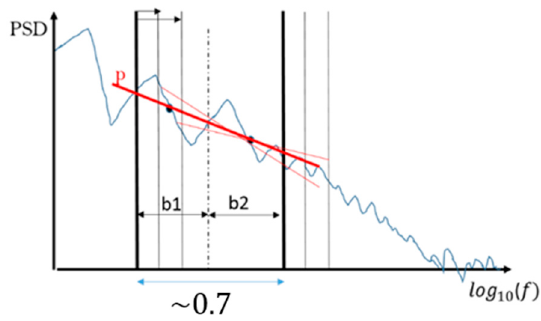
Figure 1. Schematic of the procedure used for estimating the spectral slopes in 39 frequency bands of constant width (~0.7 decade in log 10 scale) between 0.1 and 40 Hz. p is the slope of the thick red line obtained from a linear fit of the spectral domain delimited by the two thick vertical lines. The thin red lines show the linear fits for two spectral domains after shifting by 0.05 and 0.1 decade as indicated by the 2 horizontal arrows and the thin vertical lines (see text for more details)